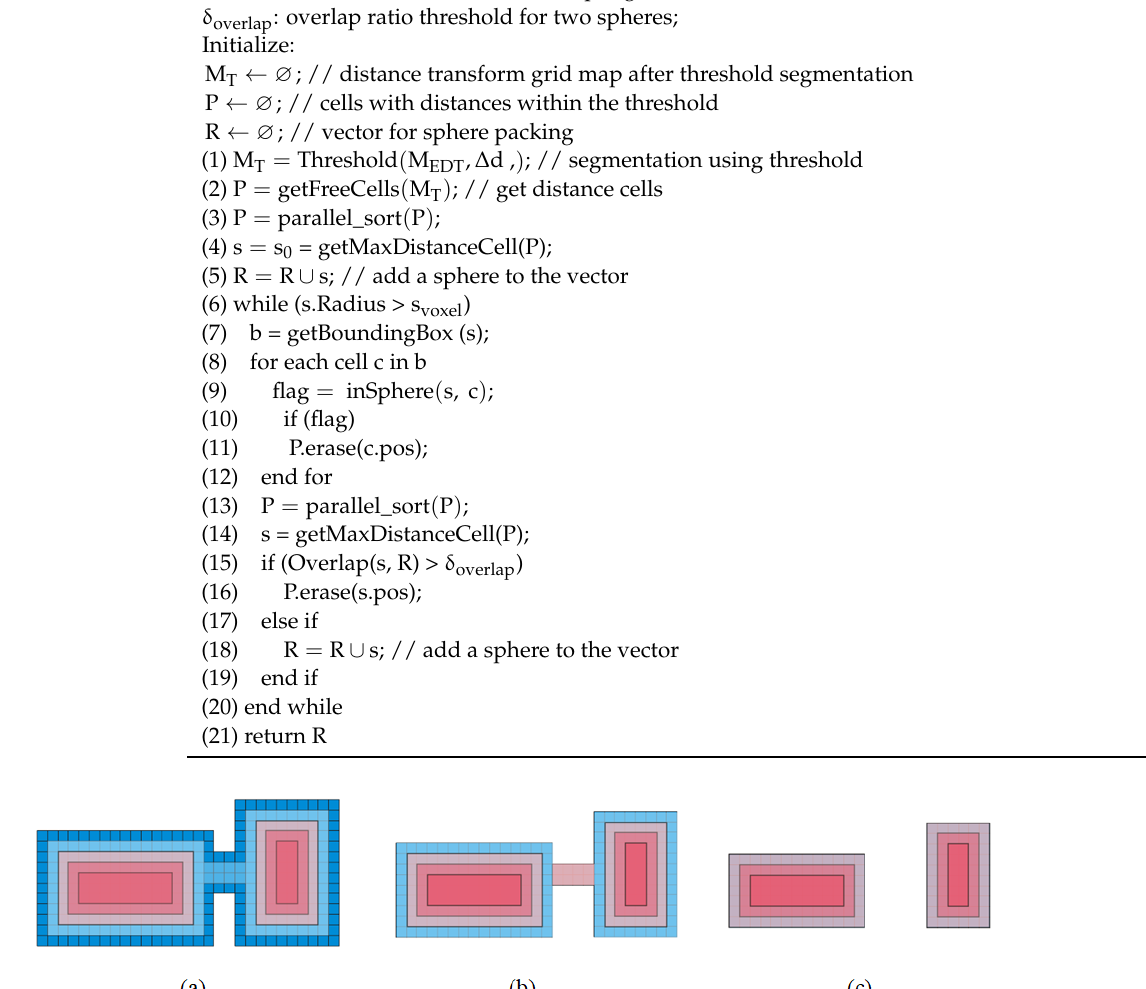
Figure 5. Segmentation results of a distance map obtained using different thresholds; the local maxima of DTs always lie in the center of a room. ( a ) Initial DT map; ( b ) segmentation result of the distance map obtained using small threshold; ( c ) segmentation result of the distance map obtained using a threshold equivalent to the door width.